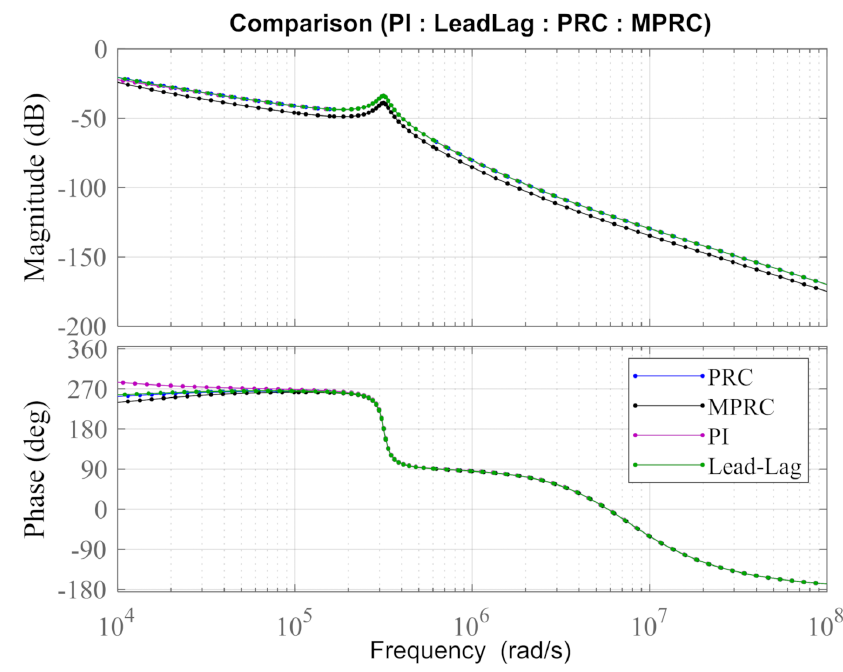
Figure 5. Bode plot comparison of PI, lead–lag, PRC, and MPRC.